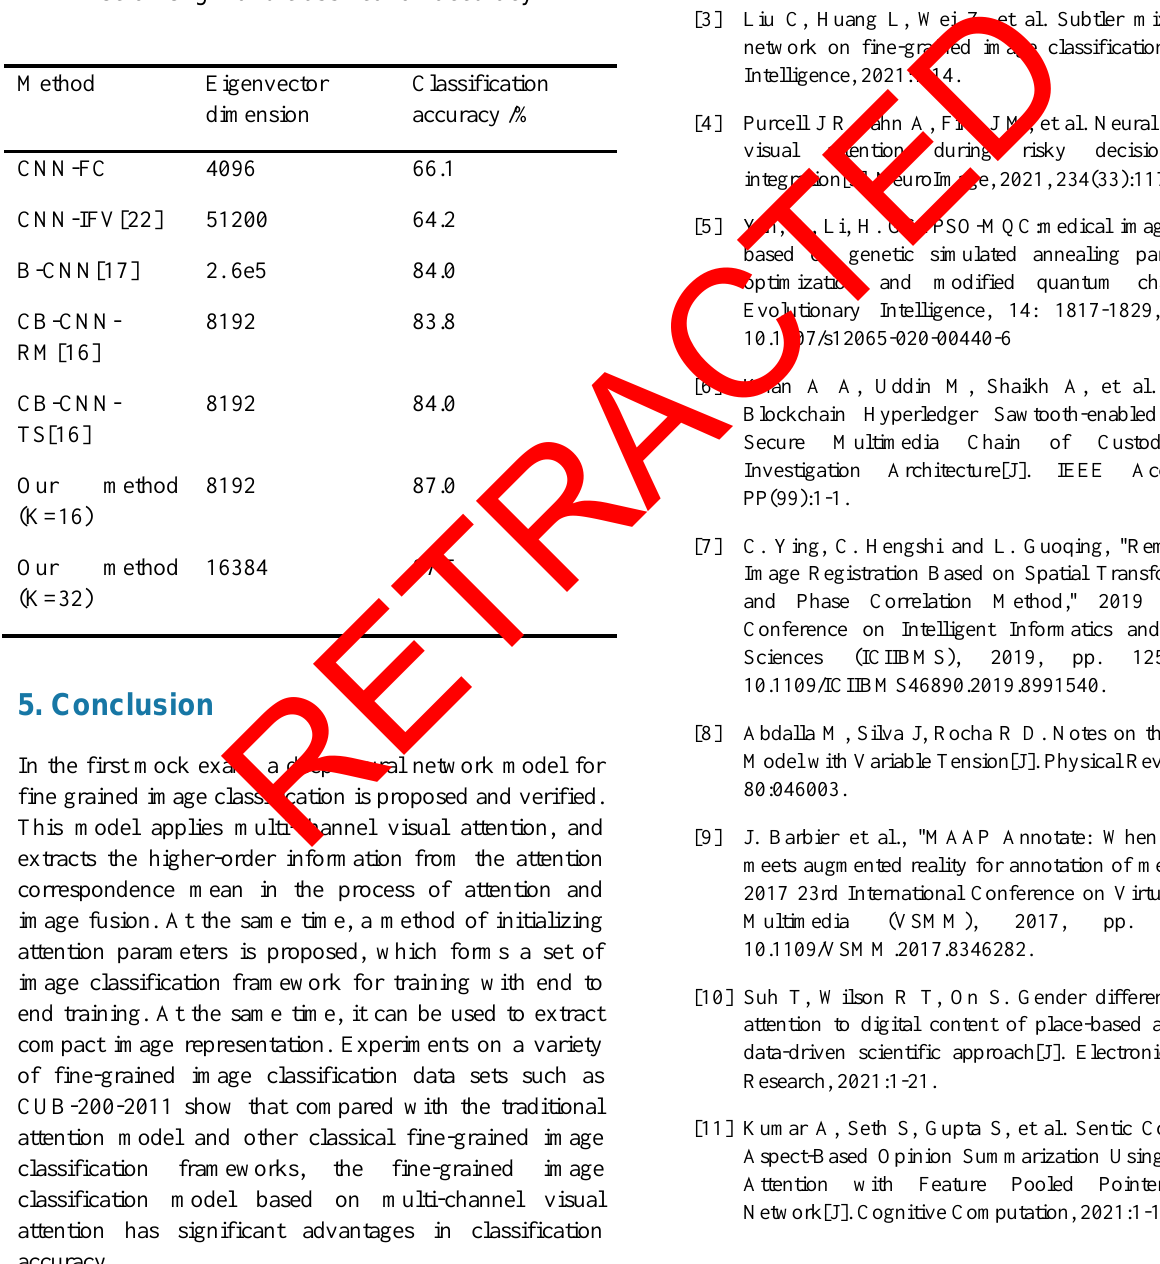
Table 4. Comparison of different models’feature vector length and classification